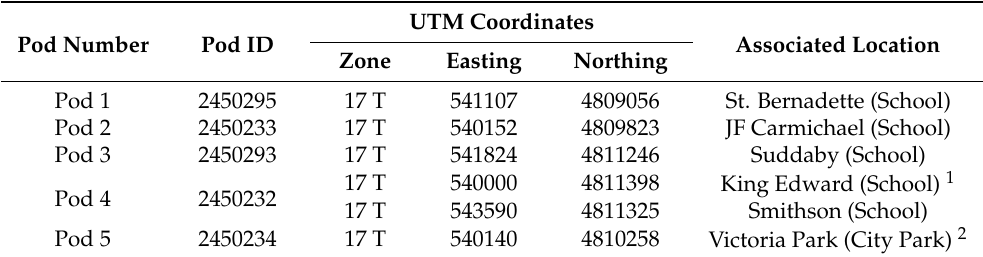
Table 2. Classification, UTM Coordinate location, and elementary school associated with each sensor pod in the low-cost sensor network. UTM Pod ID